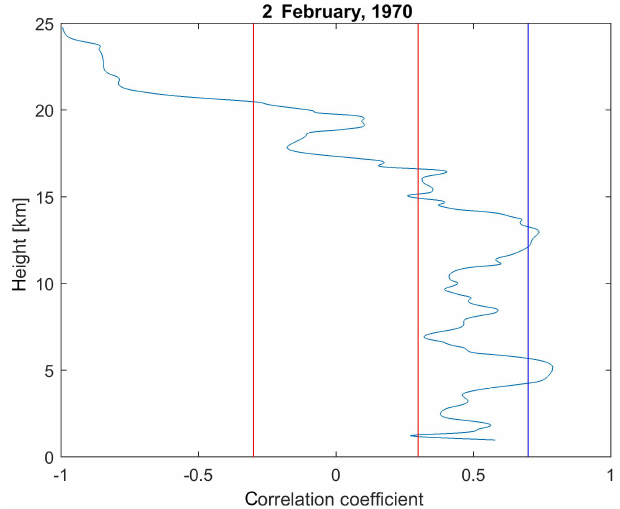
Figure 4. The vertical profile of correlations between the corrected potential temperature differences and the ozone differences from 2 February 1970 at Hohenpeissenberg. The red vertical lines are the borders for the laminae induced by the planetary waves and the blue vertical line is the border for gravity wave